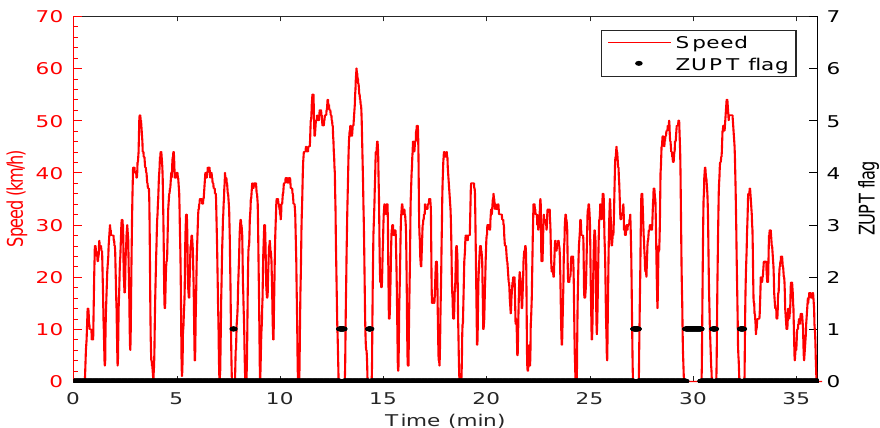
Figure 4. Vehicle speed and Zero-Velocity Update (ZUPT) flag of the first trajectory.